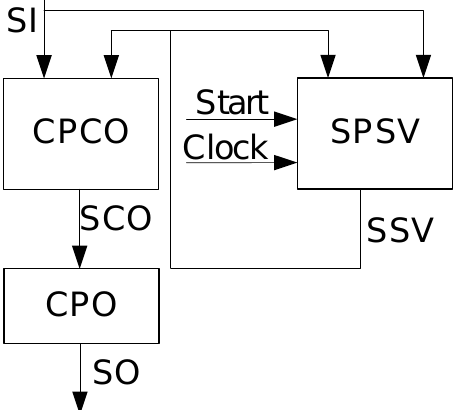
Figure 4. Structural diagram of Mealy FSM A 2